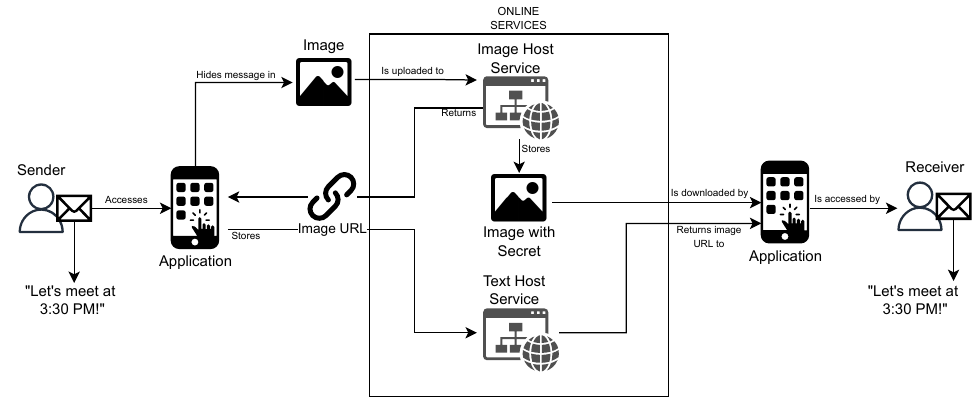
Figure 1. Reference